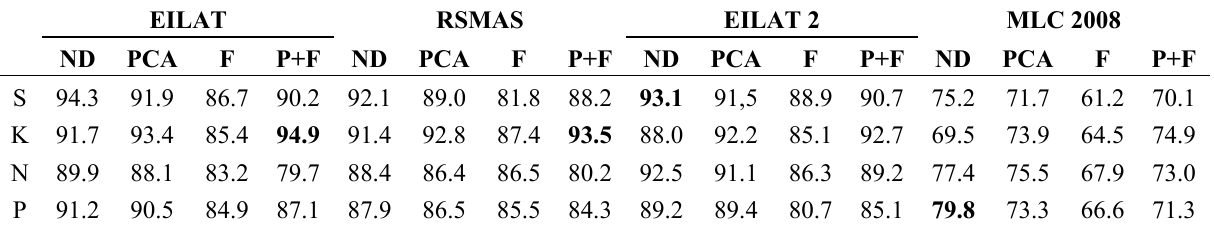
Table 7. Overall accuracy (%) with different dimension reduction and classification methods (support vector machine with radial basis kernel having one to all scheme (SVM), k-nearest neighbor (KNN), multi-layer back projection neural network (NN) or probability density weighted mean distance (PDWMD)) as evaluated with the EILAT, RSMAS, EILAT 2 and MLC 2008 datasets. In the table, principal component analysis (PCA), Fisher kernel (F), combination of principal component analysis and Fisher kernel (P+F) and no dimension reduction (ND) are applied. Moreover, SVM, KNN, NN and PDWMD are represented as S, K, N and P, respectively. In this experiment, fixed configurations on the rest of the steps are as follows. Image enhancement: contrast limited adaptive histogram specific (CLAHS); feature extraction: completed local binary pattern (CLBP), grey level co-occurrence matrix (GLCM), Gabor filter response, opponent angle and hue channel histogram; kernel mapping: L1 normalization; prior: class frequency. EILAT RSMAS EILAT 2